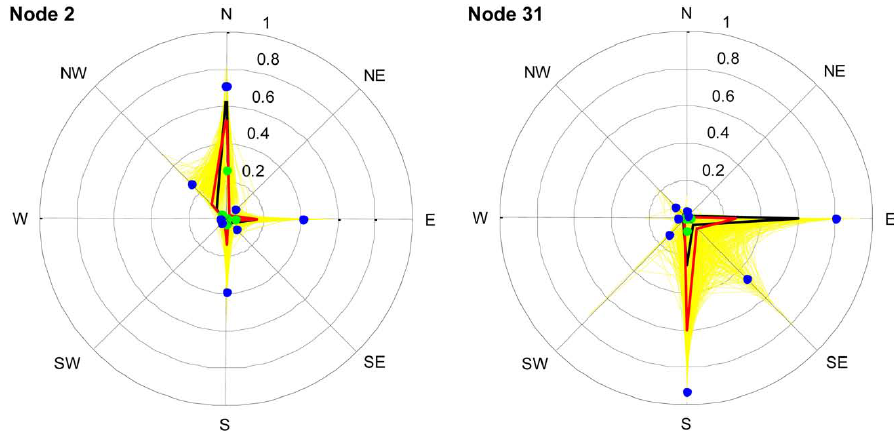
Fig. 12. Comparison between 2010 and 2050 projections (nodes 2 and 31, see Fig. 1). Black: 2010 annual mean frequency. Red: 2050